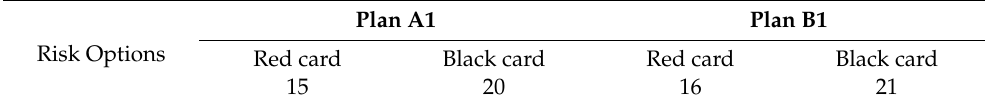
Table A1. Test Games (Yuan). Plan A1 Plan B1 Risk Options Red card Black card Red card Black card